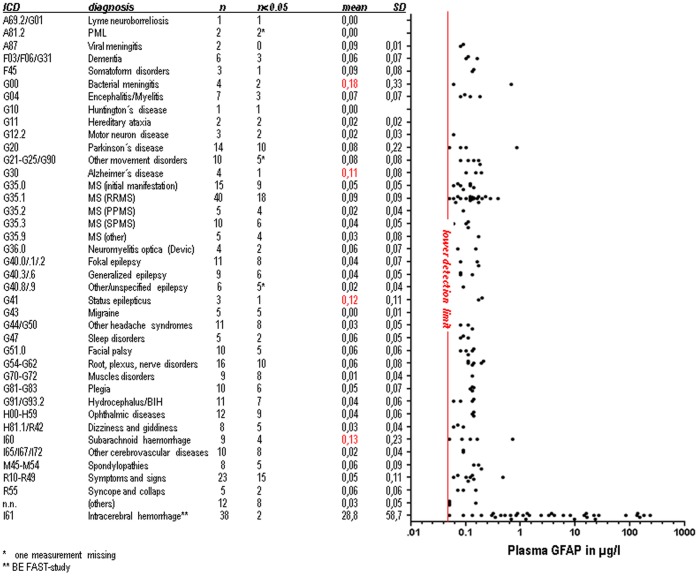
Patients are grouped according to discharge diagnosis (“ICD” = International Classification of Diseases).“n” depicts the number of patients per diagnosis. “n<0.05” displays the number of patients per diagnosis with GFAP values below the lower detection limit of the used immunoassay. The remaining values (those above the lower detection limit) are displayed as individual values in the graph. Individual patients with increased GFAP values are easy to recognize. Mean GFAP values and standard deviation (SD) are also provided for each diagnosis. The diagnoses with the three highest mean GFAP values are labelled in red. * = GFAP value of one sample is missing. ** = Results of the BE FAST study for comparison [4].